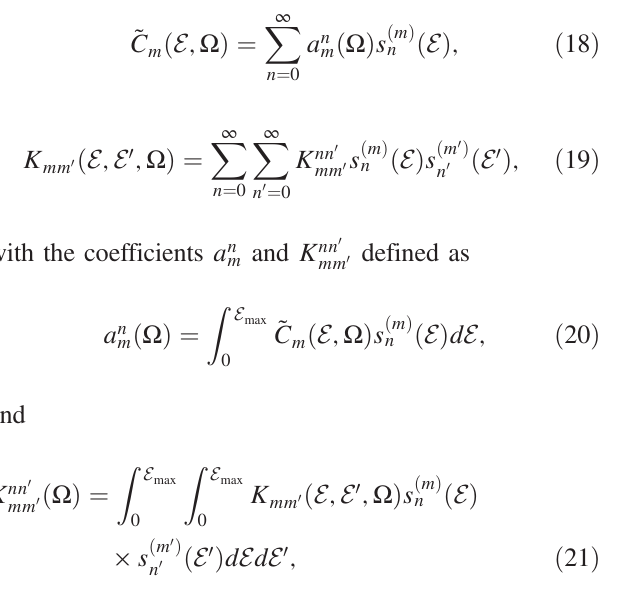
respectively. The examples of the orthogonal functions which can be used in practice will be discussed in Sec. II